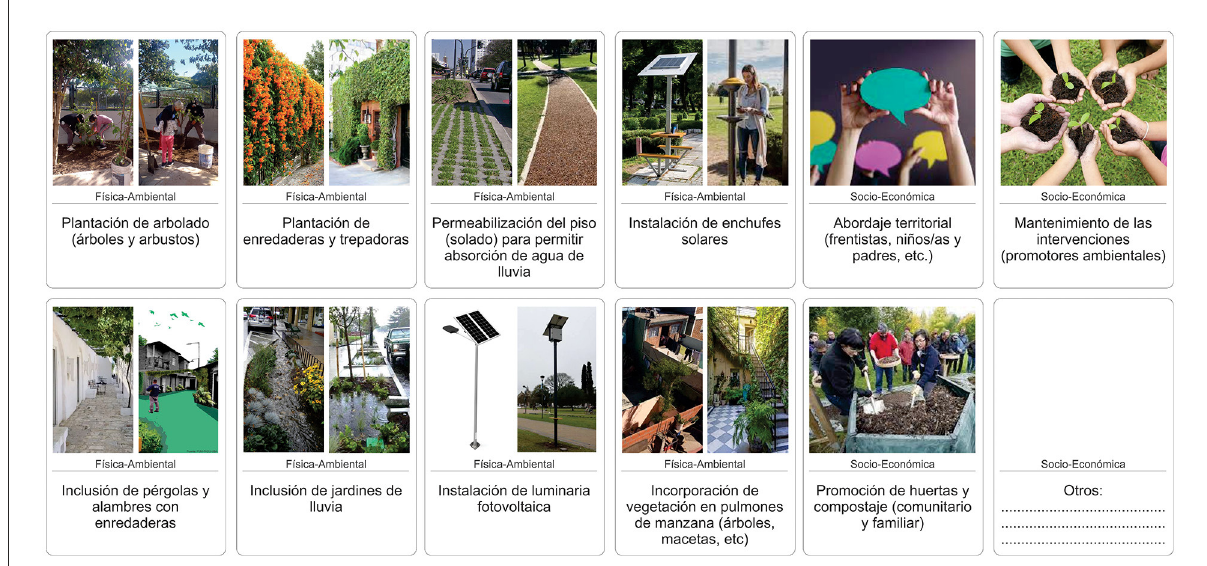
FIGURE7 Tool kit to aid design of interventions during participatory planning workshop: Source: TUC